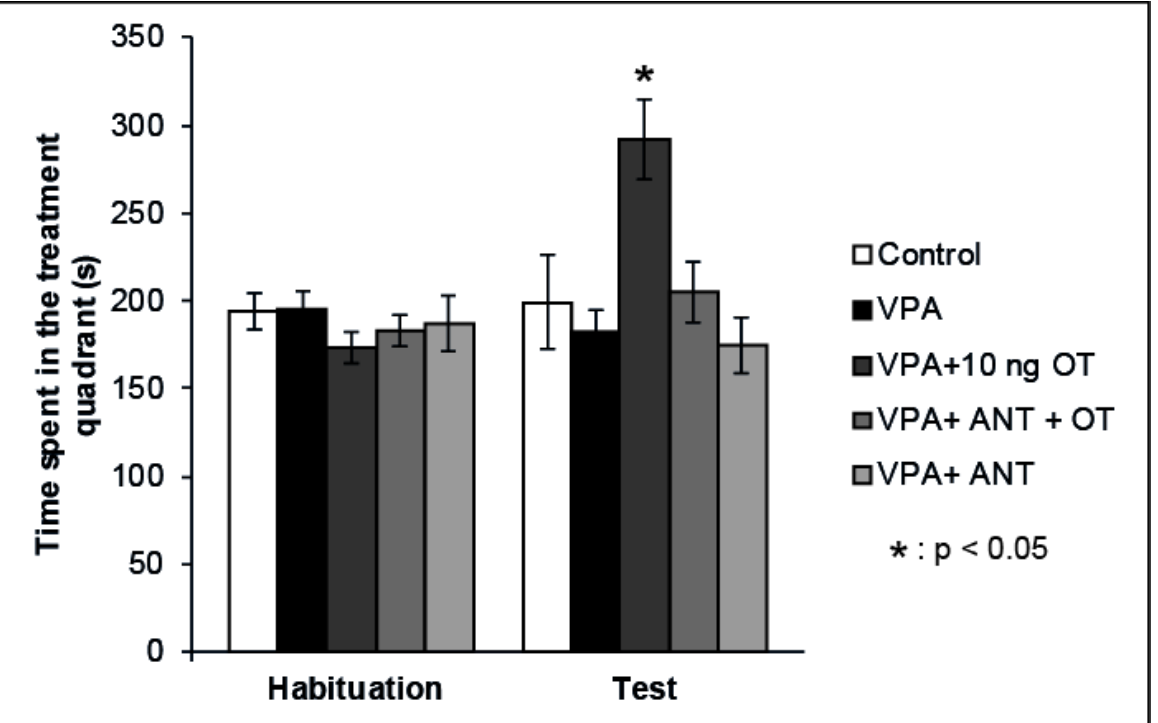
Figure 2. Effects of OT and the OT receptor antagonist injected into the CeA of autistic rats on the conditioned place preference (CPP) test. Columns represent mean time spent in the treatment quadrant (±S.E.M.) during Habituation and Test sessions. Control: neurotypical/sham male Wistar rats receiving intraamygdaloid PBS ( n = 6); VPA: intrauterine VPA-treated rats showing autistic-like behavior ( n = 7); VPA + 10 ng OT: animals showing autistic-like behavior, microinjected with 10 ng OT ( n = 7); VPA + ANT + OT: animals with autistic-like behavior, microinjected with 20 ng OT receptor antagonist and 10 ng OT ( n = 7); VPA + ANT: animals with autistic-like behavior, microinjected with 20 ng OT receptor antagonist ( n = 7); * p < 0.05; for more explanation, see the